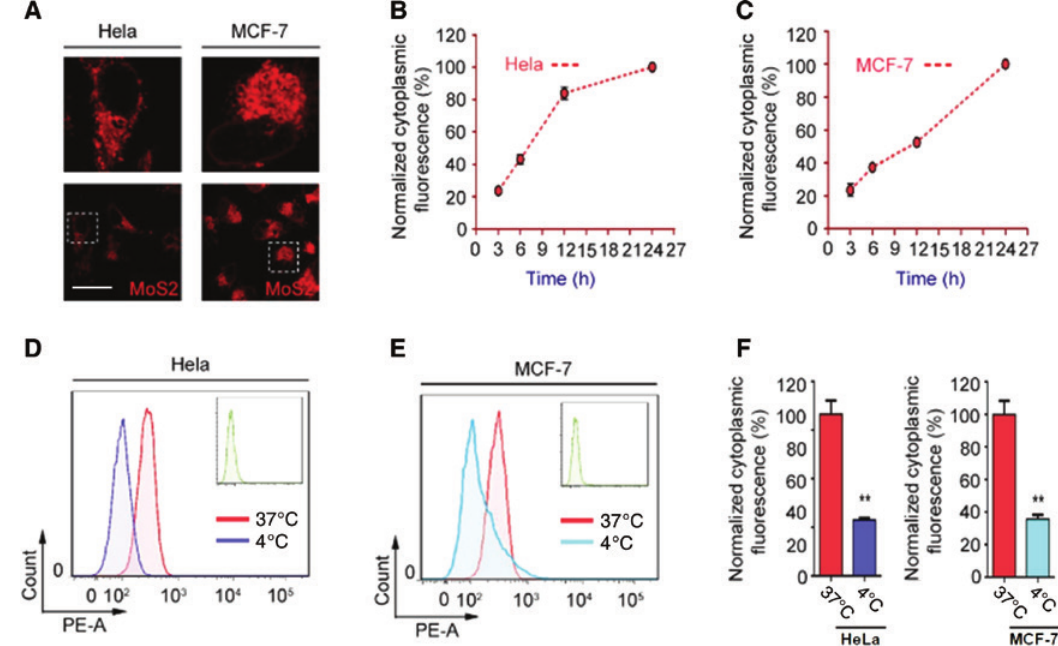
Figure 2: Effect of temperature on the internalization of WS2-based NSs. (A) The ingested fluorescence of WS -based NSs was monitored by CLSM after 2-h incubation. The enlarged images are shown in the top 2 row. Scale bars: 10 μ m. The dynamic internalization of fluorescent WS2-NSs was monitored by flow cytometer and quantified in (B) HeLa cells and (C) MCF-7 cells. Effect of temperature (37 and 4 ° C) on WS2-based NSs’ uptake was measured by flow cytometer after 2 h incubation in (D) HeLa cells and (E) MCF-7 cells. (F) The cytoplasmic fluorescence was statistically analyzed. Scale bars: 10 μ